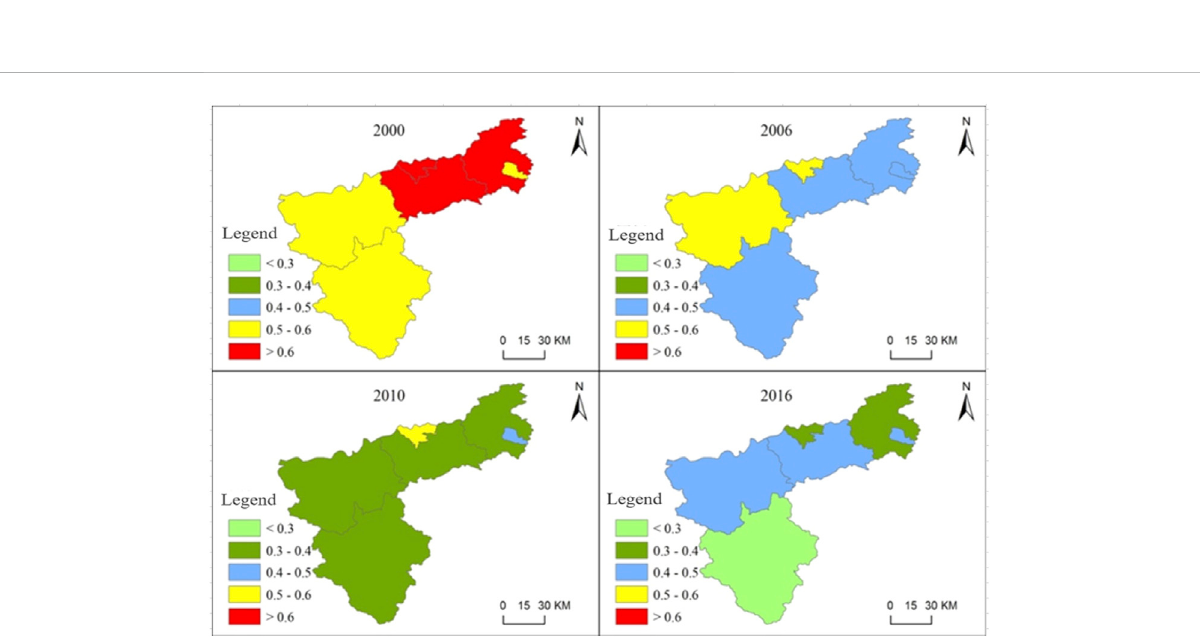
FIGURE 10 Spatial changes in vulnerability of the farmland system in Sanmenxia